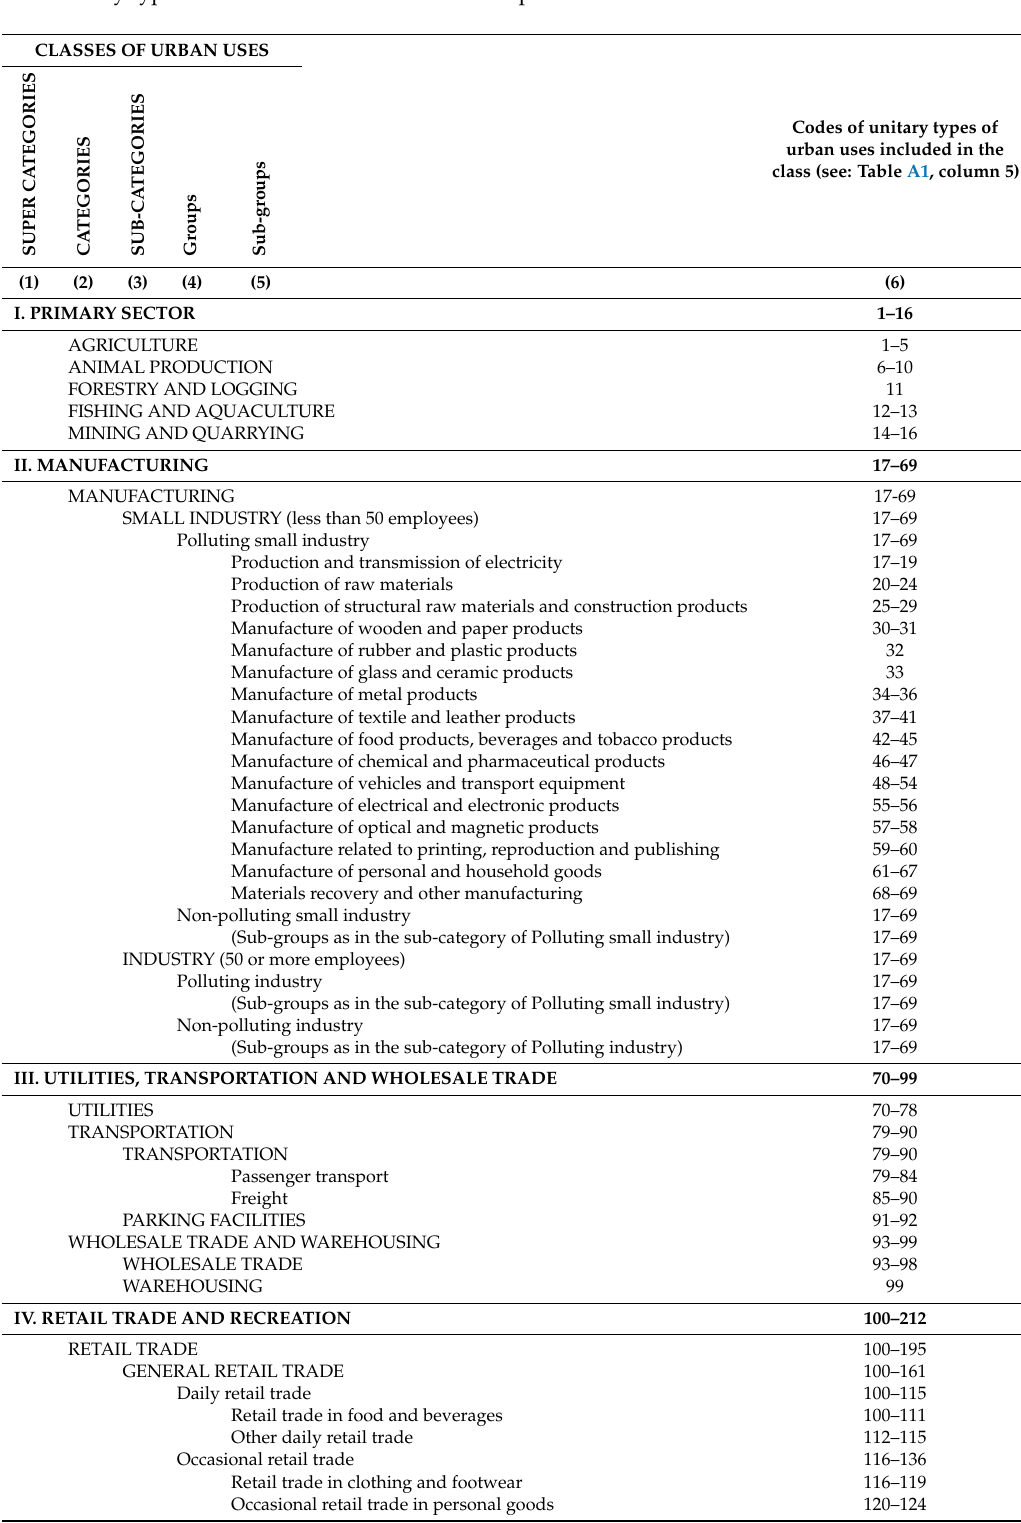
Table A2. Classification of the unitary types of urban uses into super-categories, categories, sub-categories, groups and sub-groups (columns 1, 2, 3, 4 and 5 respectively), on the basis of urbanological and legal criteria and cartographical constraints. Column 6 gives the code numbers of the unitary types of urban uses included in each separate set of uses. CLASSES OF URBAN USES